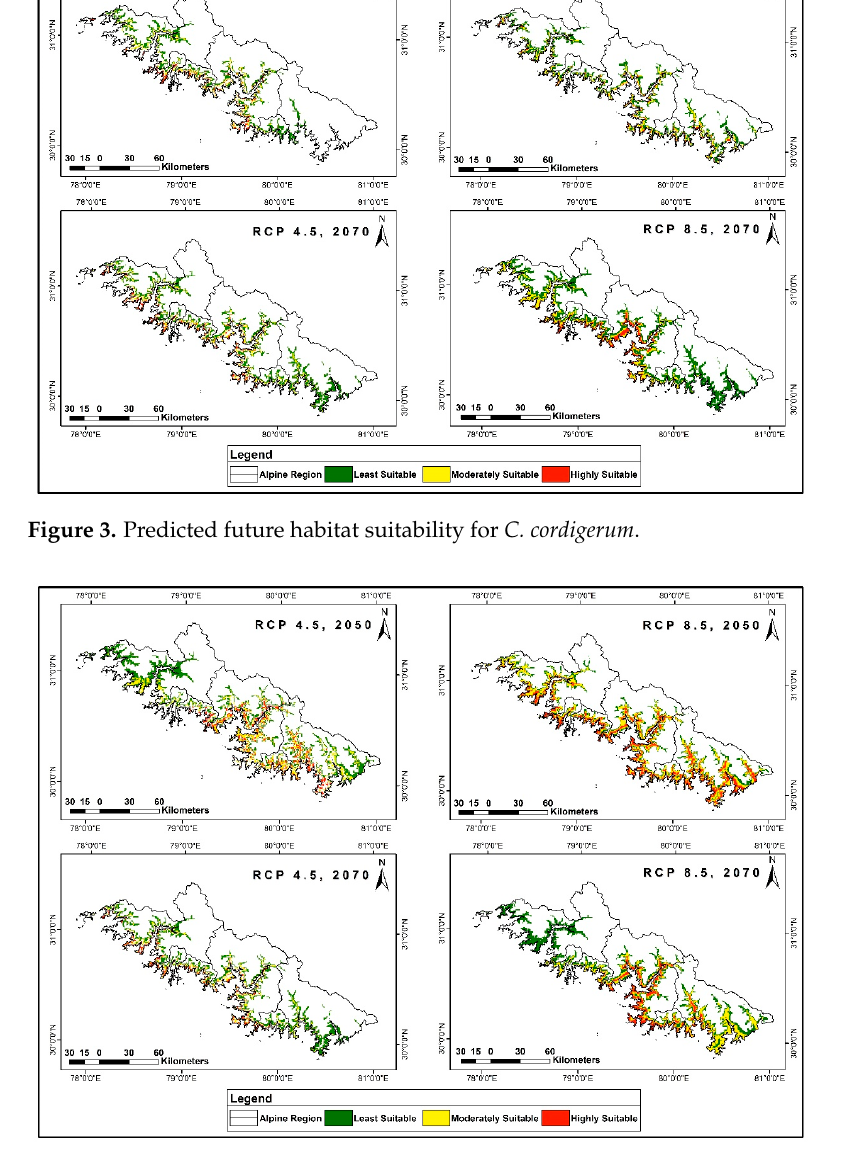
Figure 4. Predicted future habitat suitability for C. elegans. Table 2. Prediction accuracy of C. himalaicum species under future climatic